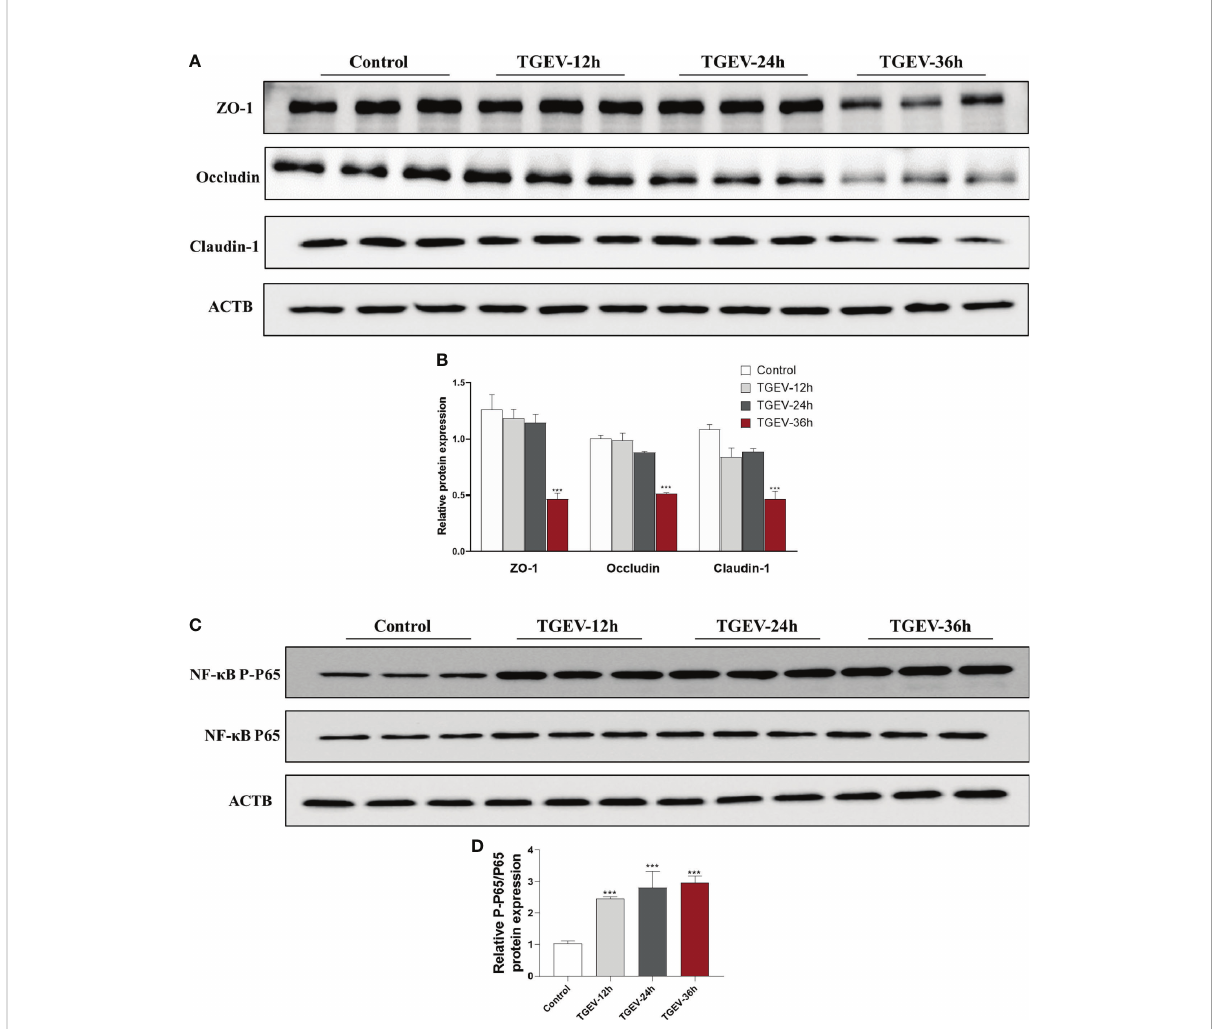
FIGURE 9 Effects of TGEV infection on intestinal barrier injury of IPEC-J2 cells. IPEC-J2 cells were infected with TGEV (MOI=1) for 12 h, 24 h and 36h. (A-D) Immunoblot analysis and quanti fi cation of ZO-1 , Occludin , Claudin-1, NF- k B P-P65 and NF- k B P65 in IPEC-J2 cells. Data were expressed as mean ± SEM. *** p < 0.001.